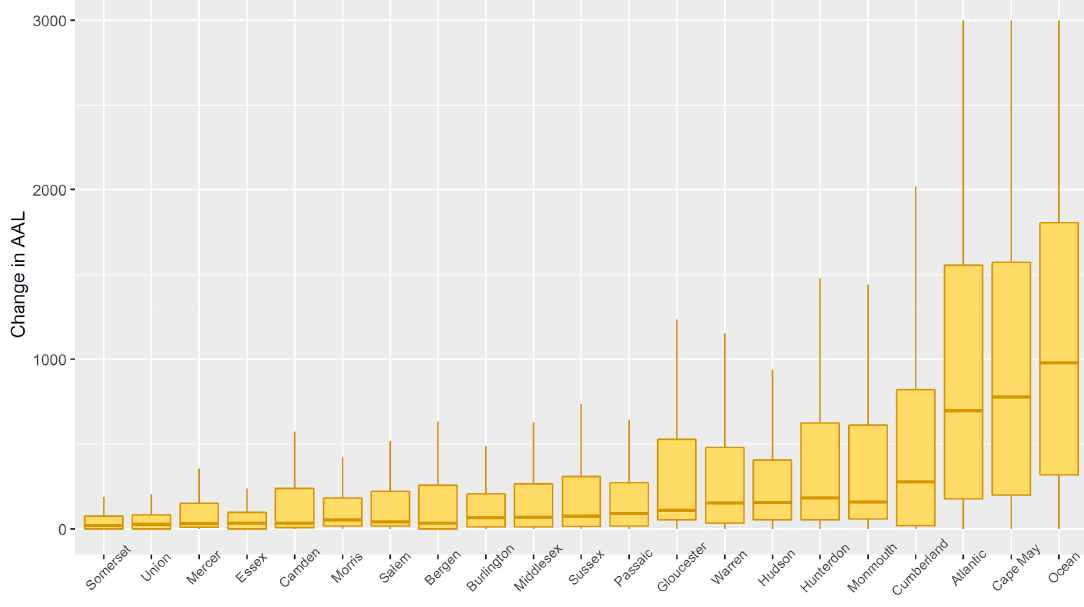
Figure 9. The range of changes in expected annual loss of properties across counties.